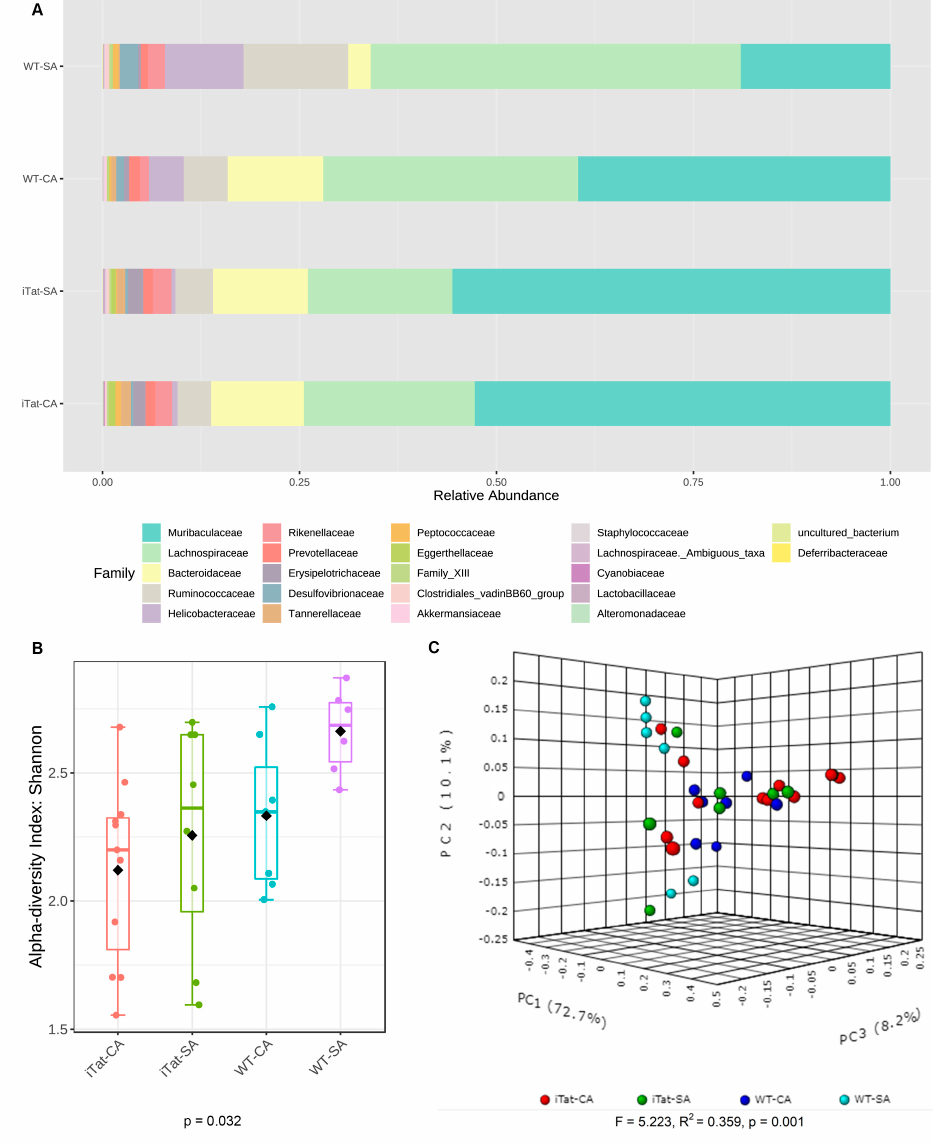
Figure 5. Effects of Tat expression and cocaine exposure on microbial abundance and diversity in the gut of 12-month female mice. ( A ). Relative abundance (%) of top 22 families of gut microbiota in four experimental groups WT-SA, WT-CA. iTat-SA, and iTat-CA were presented as a stacked bar plot. ( B ). Shannon index was calculated to determine α -diversity of the gut microbiota in four experimental groups WT-SA, WT-CA. iTat-SA, and iTat-CA, presented as a box plot, and analyzed using the Kruskal–Wallis test. The error bars were standard derivation (SD). ( C ). Bray–Curtis dissimilarity was calculated to determine β -diversity, presented as a PCoA plot, and analyzed using PERMANOVA. The percentage variations in the plotted principal component were indicated on the axes.